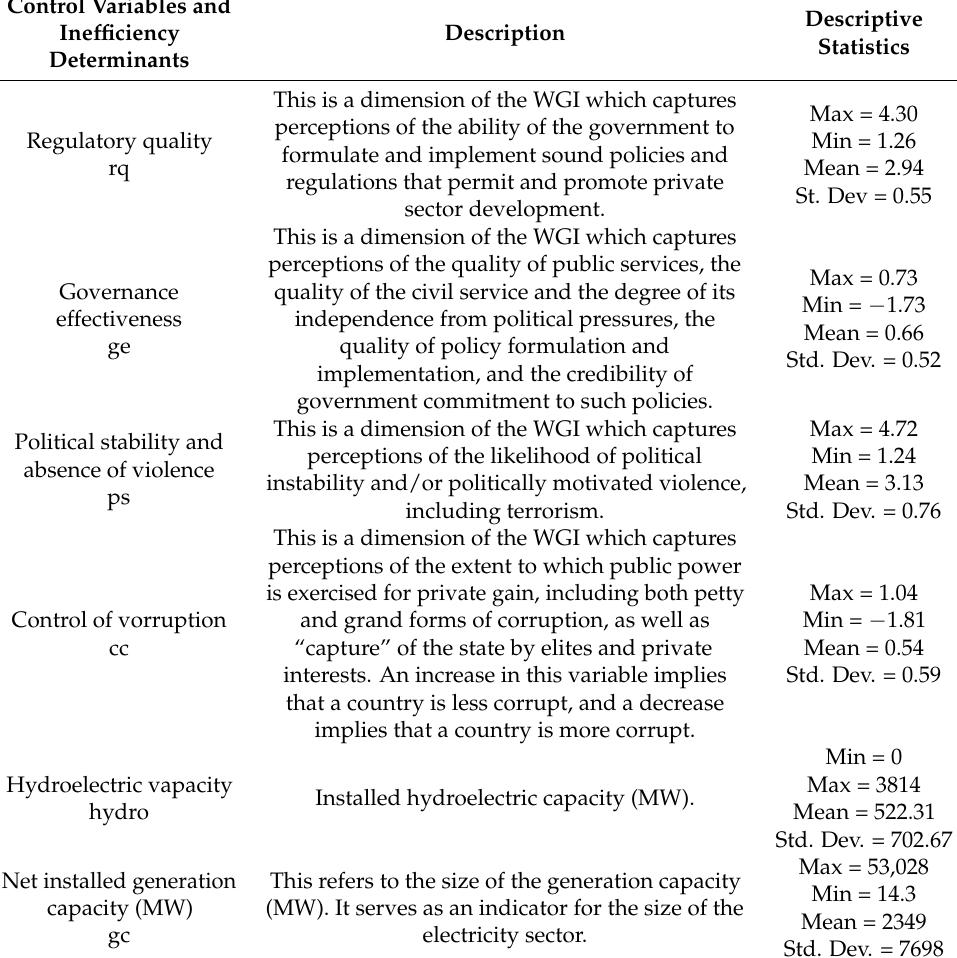
Table 3. Description of institutional variables and other sectoral characteristics (control variables and inefficiency